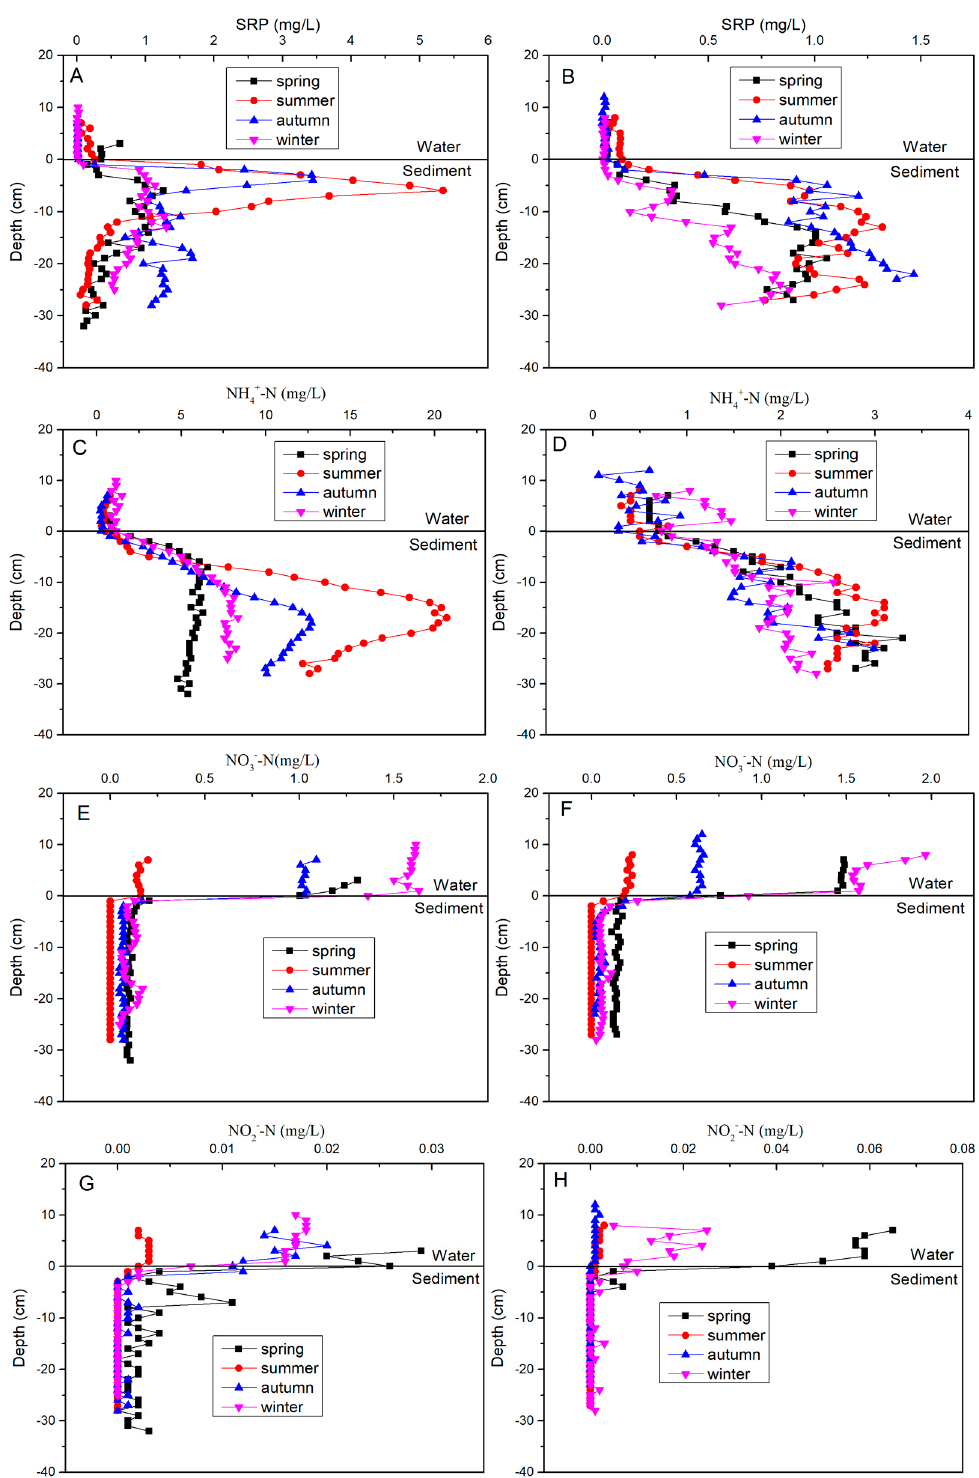
Figure 4. Depth profiles of soluble reactive phosphorus (SRP) and inorganic nitrogen in sediment porewater in different seasons from Inner Bay ( A , C , E , G ) and Outer Bay ( B , D , F , H ), samples were collected in 2007–2008.